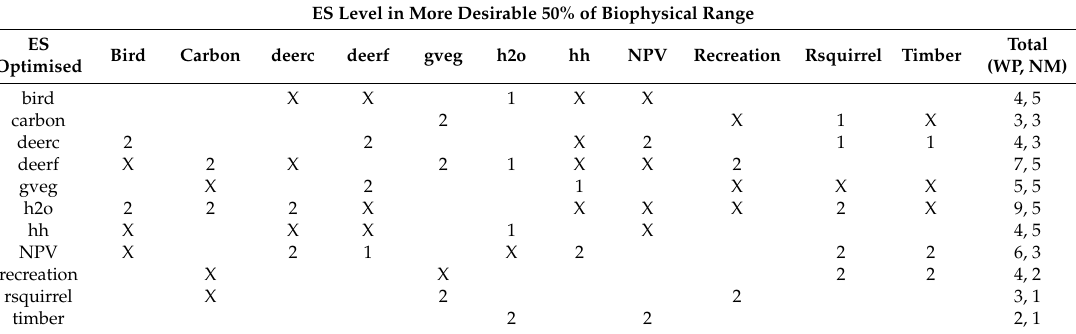
Table 6. The trade-offs between ecosystem servicess when optimising each ecosystem service separately (minimising for water sedimenation risk and maximising for all